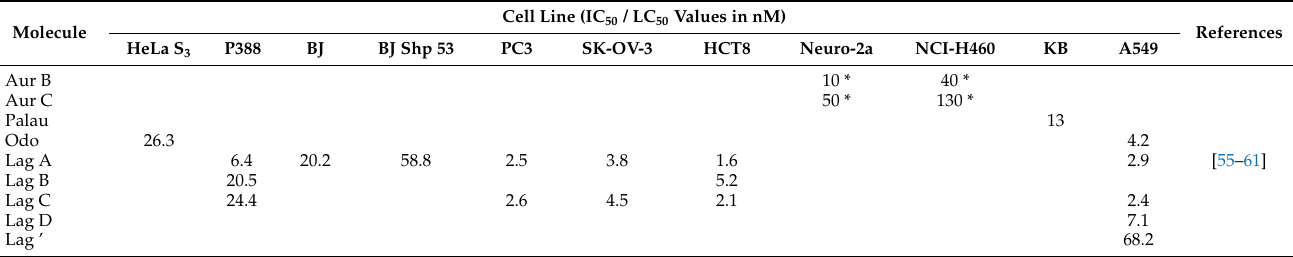
Table 5. Aurilide analog activities on cancer cell lines.